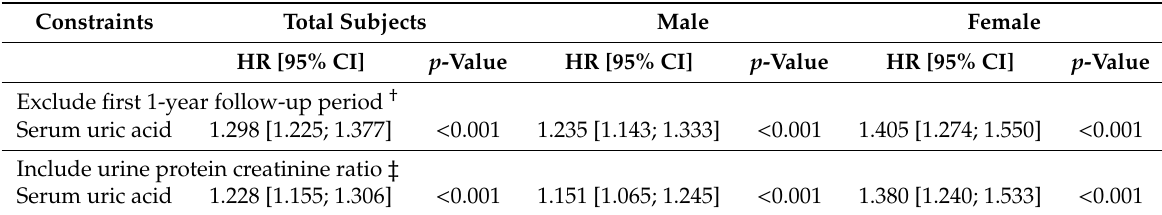
Table 3. Hazard ratio of serum uric acid for major adverse renal event with Cox proportional hazard models by sex with